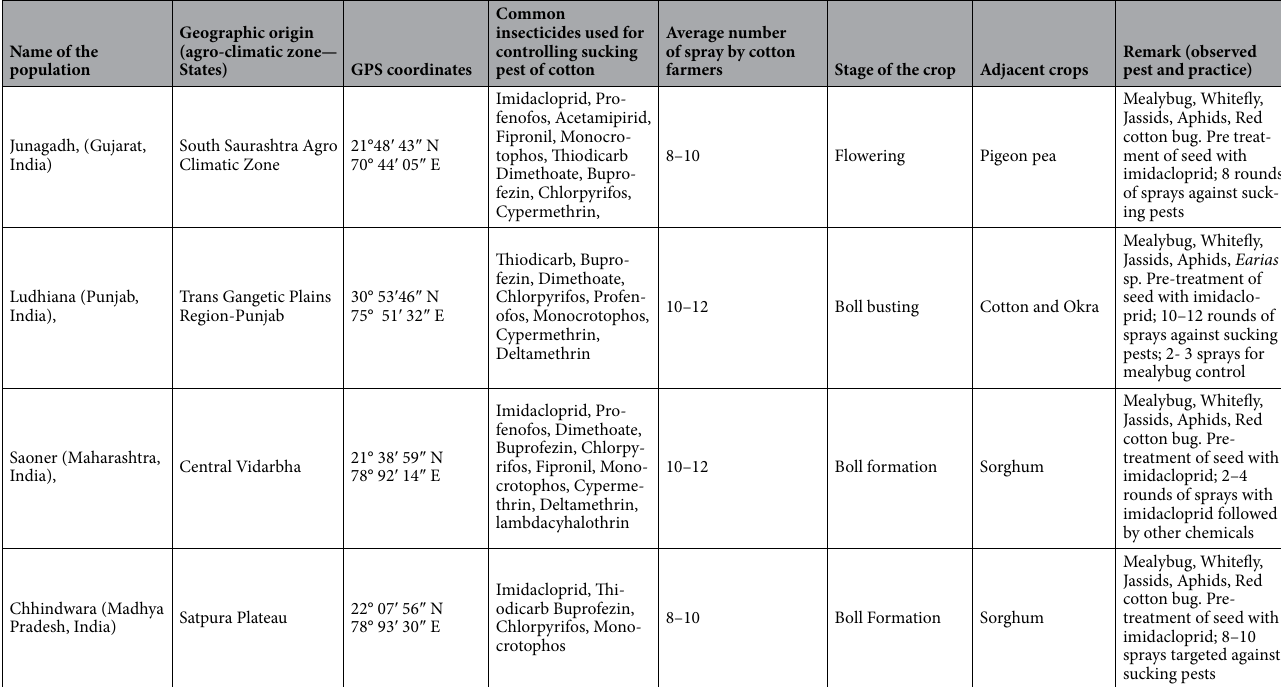
Table 1. Detailed information on Indian populations of Phenacoccus solenopsis used in the current study.